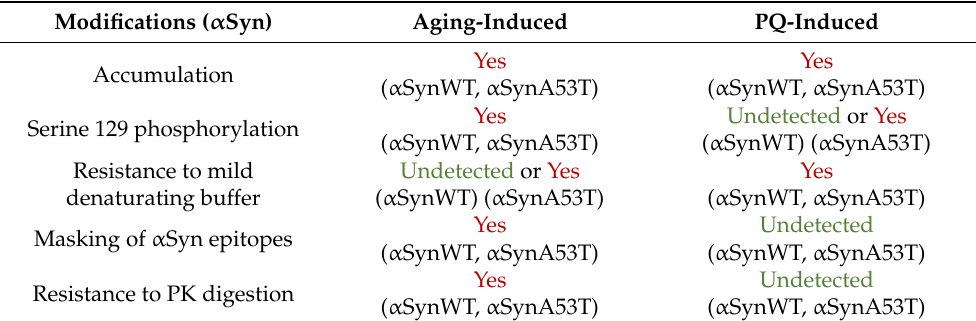
Table 2. Comparison of α Syn pathogenic progression induced during normal aging or by PQ exposure. α Syn pathogenic modifications in aged (40- to 60-day-old) or young PQ exposed flies (LT50 between 15- and 19-day-old) in flies expressing human α Syn ( α SynWT or α SynA53T) under the ELAV